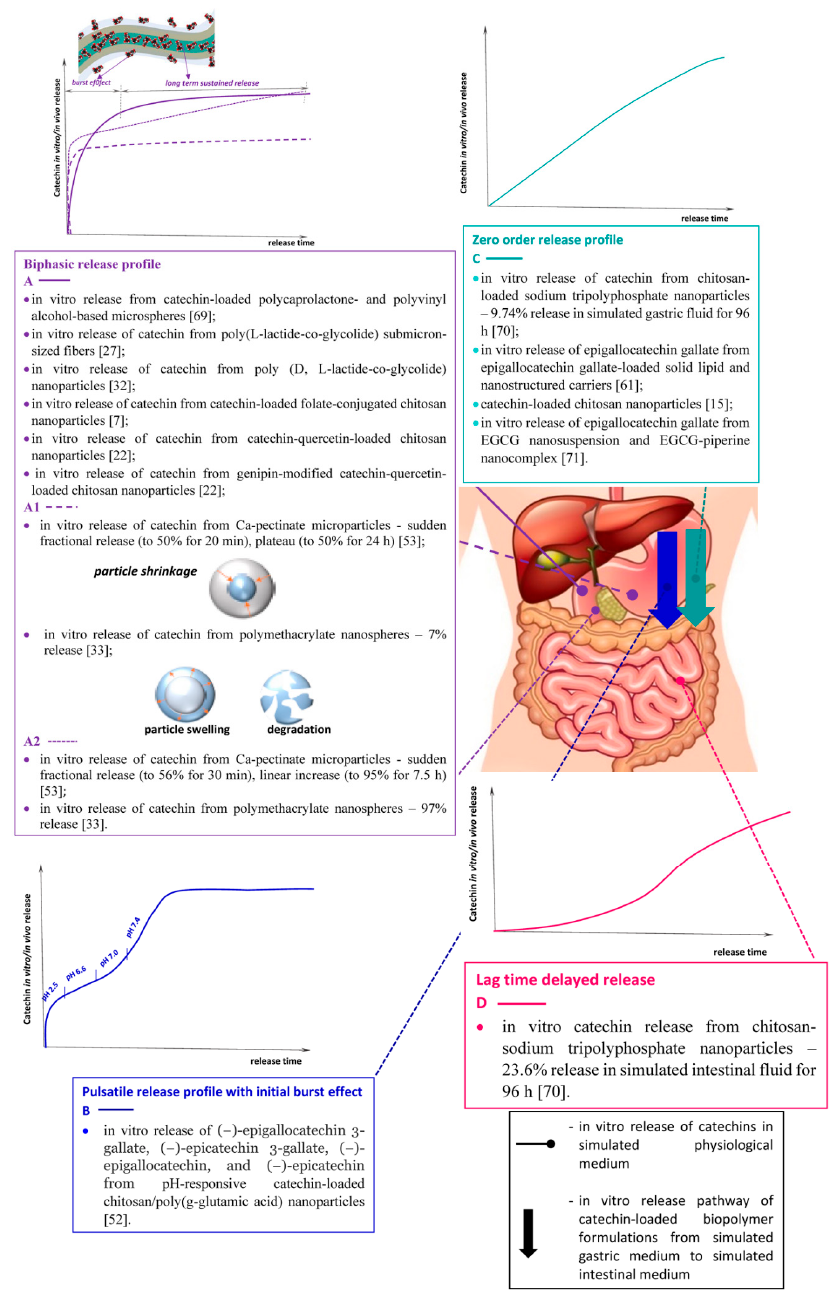
Figure 6. Common in vitro release profiles and release capacity of various catechins-loaded biopolymer matrices in simulated gastrointestinal medium [7,15,22,27,32,33,52,53,61,69–71].